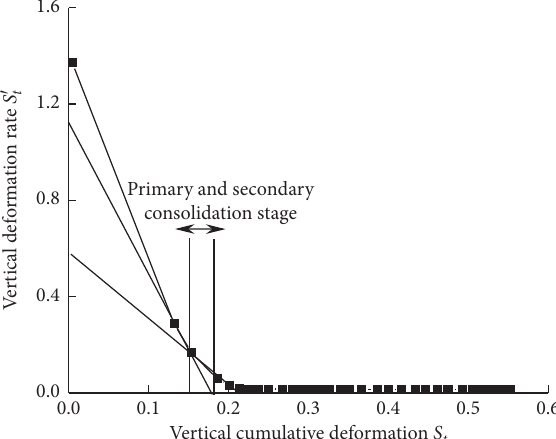
Figure 5: S − S t ′ t curve at E 0